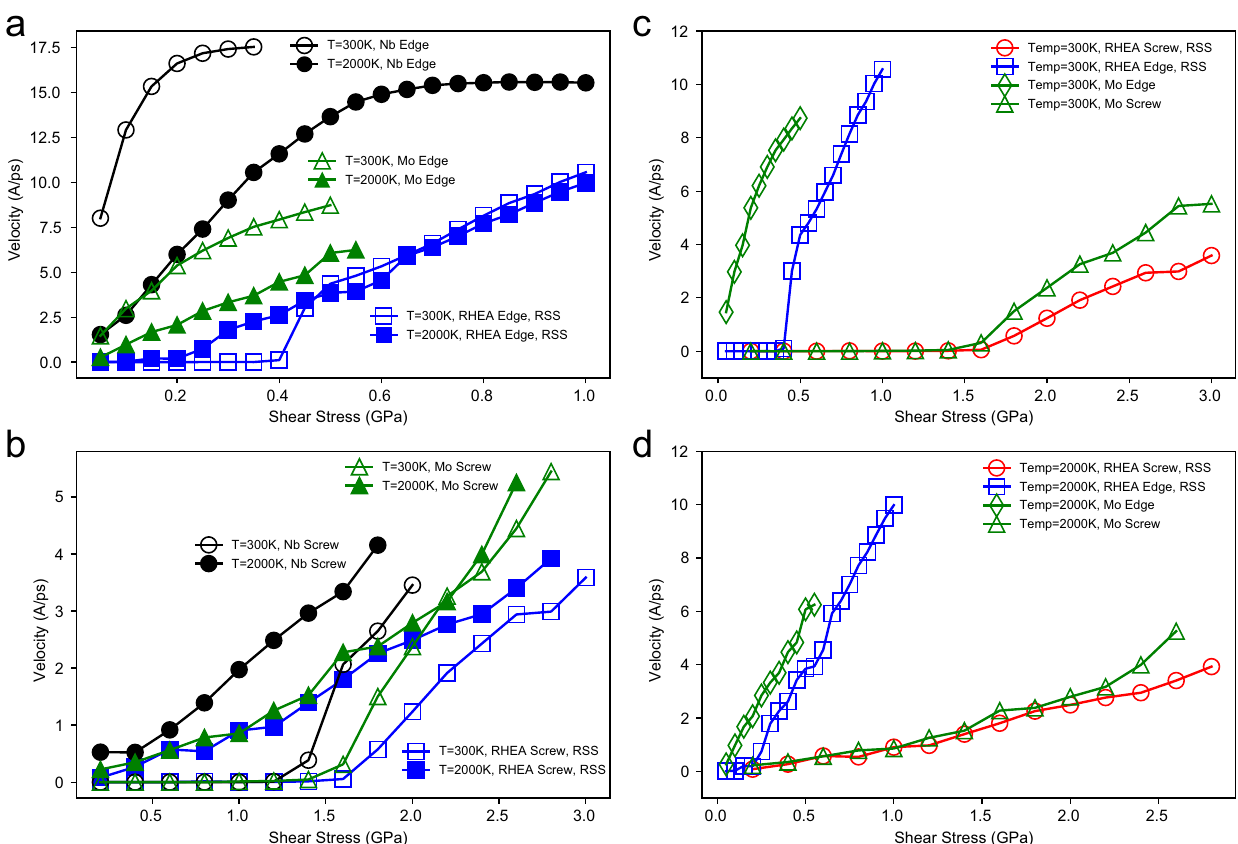
Fig. 7 Comparison of dislocation velocities in the MoNbTaW RHEA and pure Mo and Nb. Velocity as a function of stress for a , edge dislocations and b , screw dislocations in the RHEA and in pure Mo and Nb at temperatures of T = 300 and 2000 K. Velocity as a function of stress for edge and screw dislocations in the RHEA and in pure Mo at temperatures of c , 300 K and d , 2000 K. For all of the results the symbols are simulation data and the solid lines are guides to the eye, connecting results for a given dislocation character (edge or screw) and given